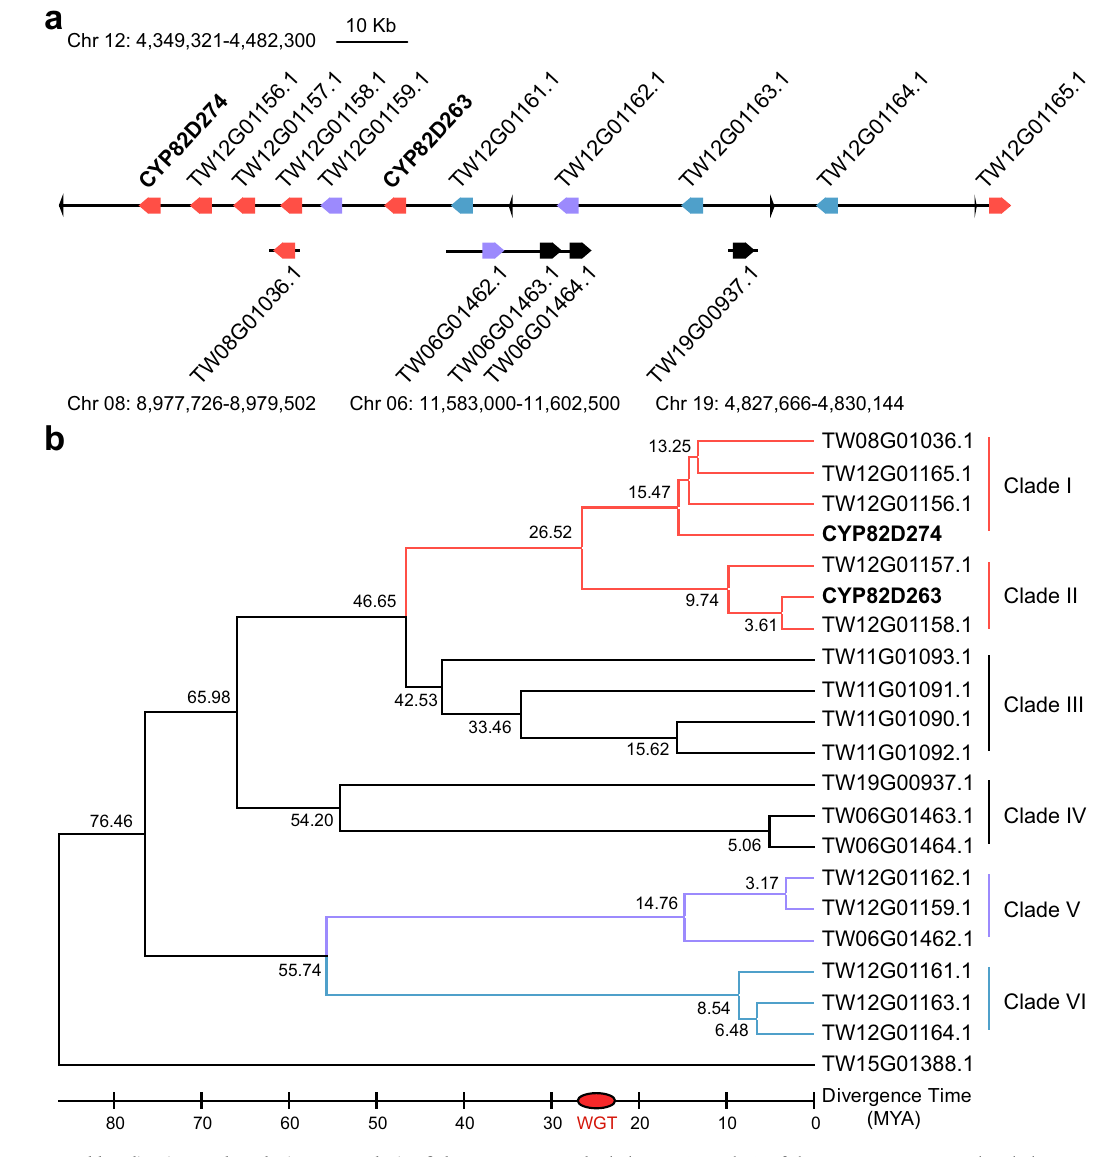
Fig. 2 | Chromosomal localization and evolutionary analysis of the CYP82D genes. a Chromosomal localization of the 133-kb tandem duplicated CYP82Ds on Chr12 encoding 11 complete genes. The same color indicates orthologous CYP82D genes and the small triangles represent the incomplete gene residues.